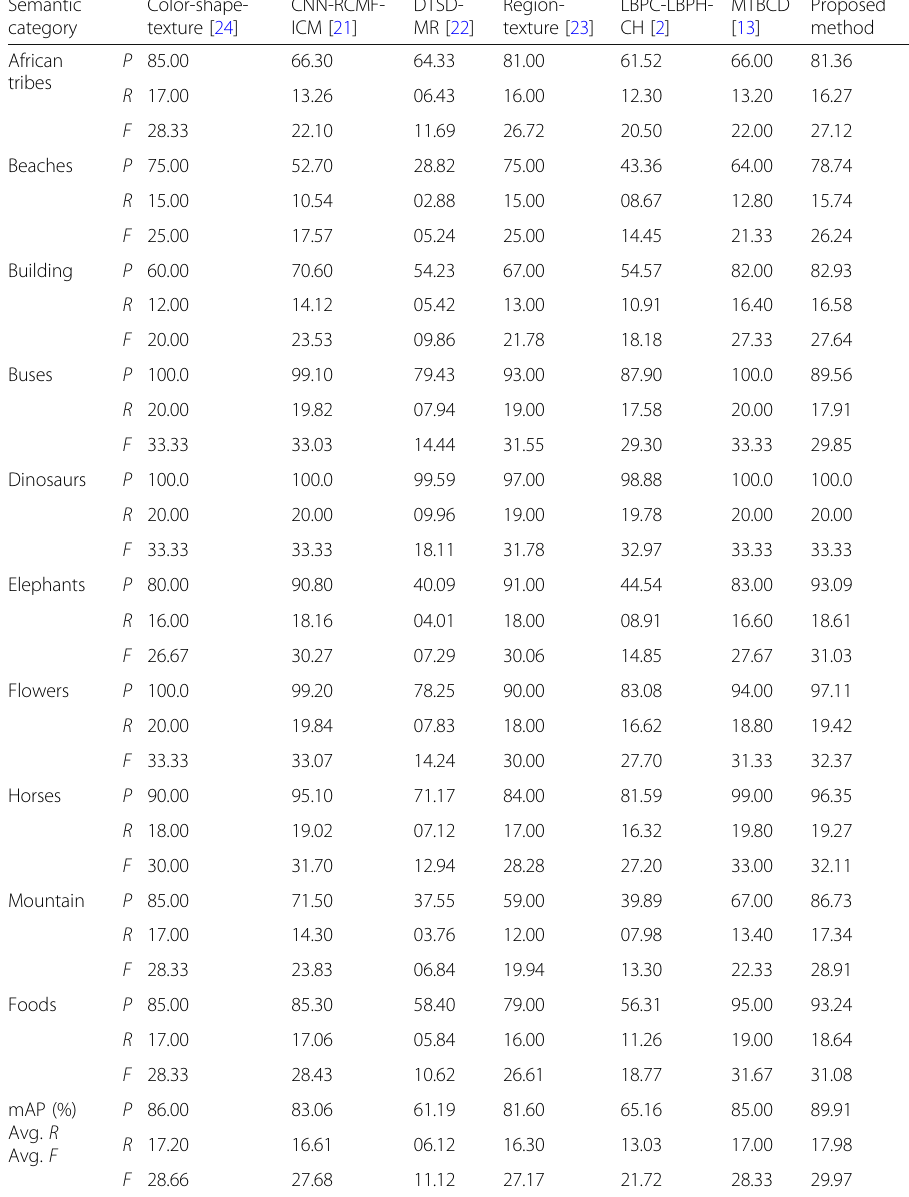
Table 3 Comparative analysis of competitive methods with a proposed method on the Corel 1000 dataset Semantic category African tribes